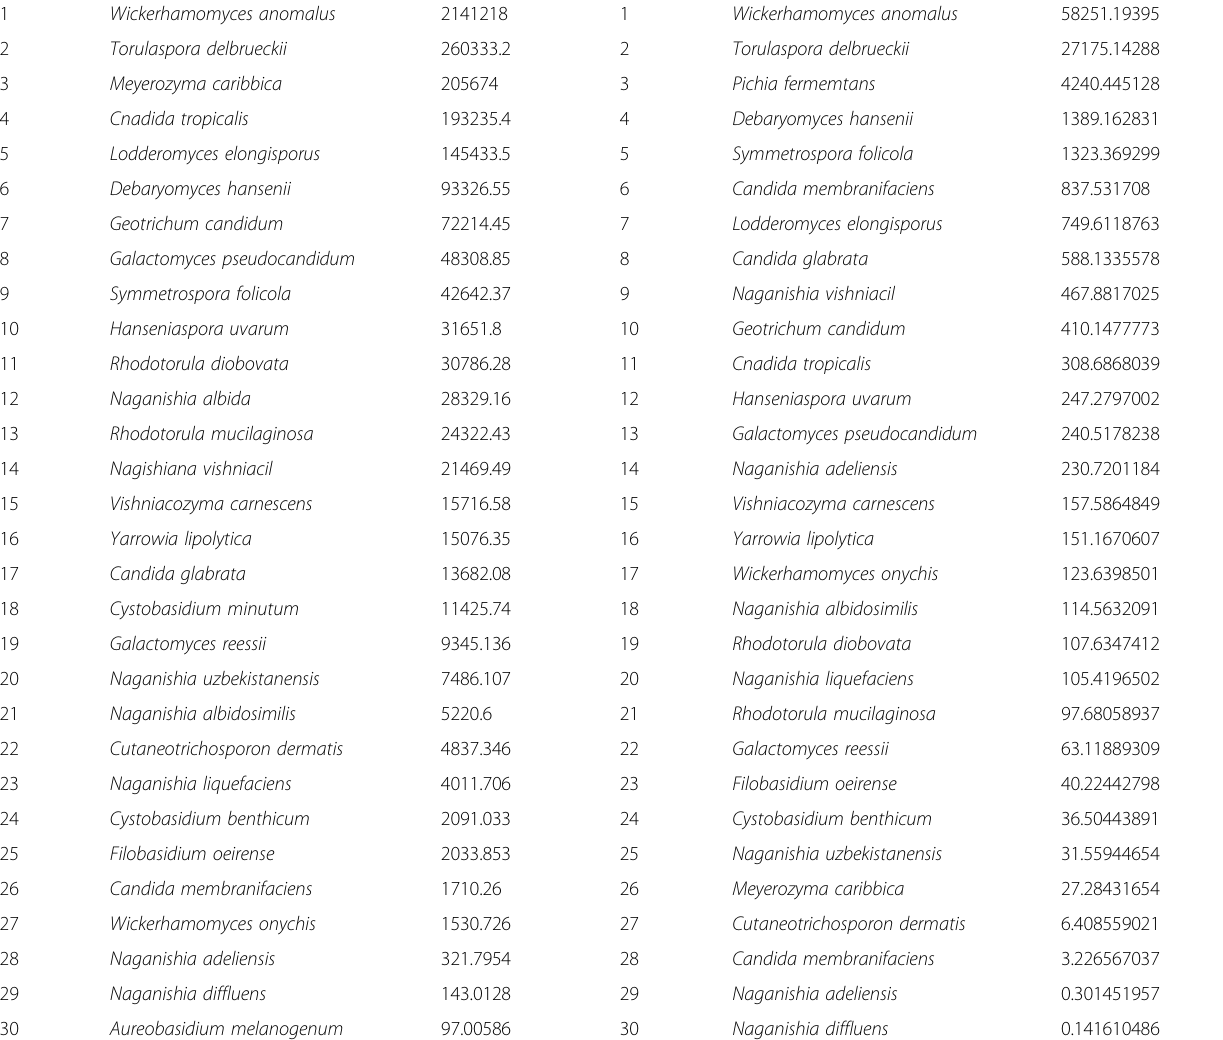
Table 2 Relative gene expression of M28 gene for 31 strains Table 3 Relative gene expression of M1 gene for 31 strains